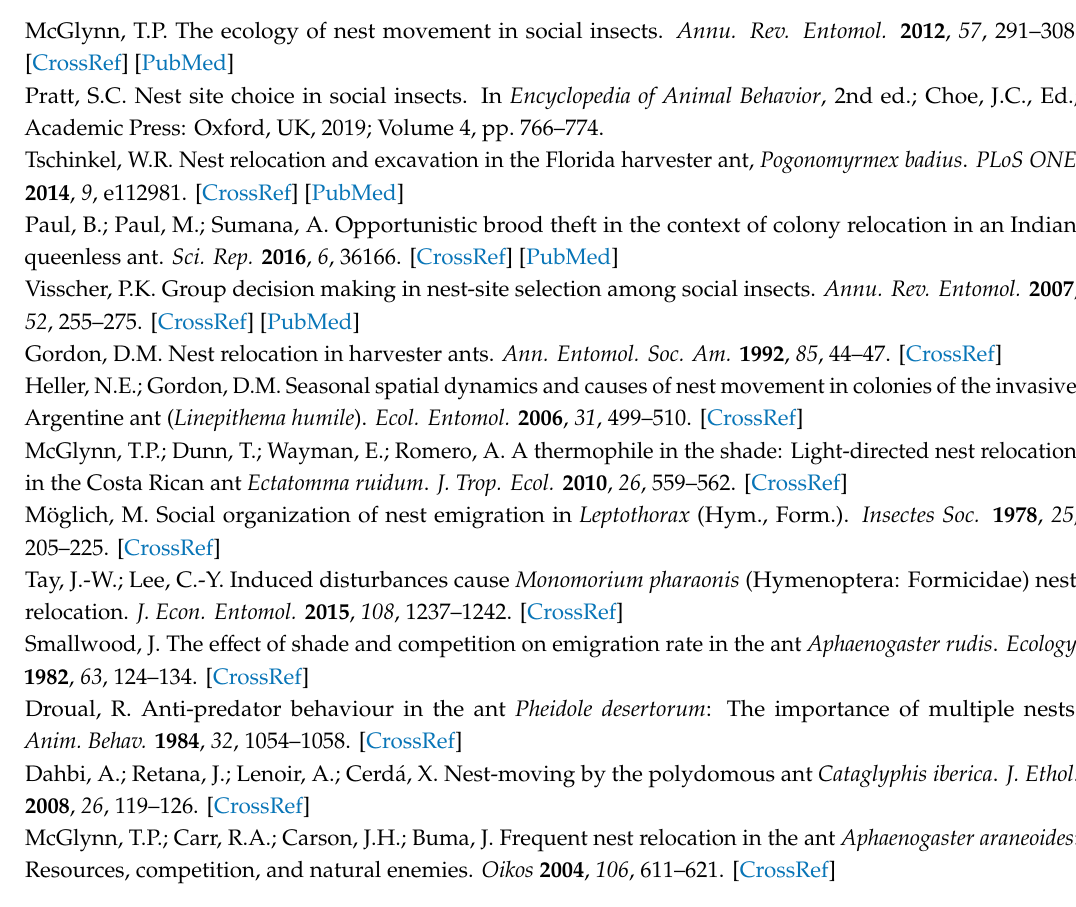
Table S1: Original composition of the Neoponera villosa colonies used in the two-choice bioassays, Figure S1: Taxon ID tree of N. villosa molecular public data, including the 10 sequences from this study (highlighted in yellow), Video S1: Characteristic recruitment behavior in Neoponera villosa . Note that two tandem pairs are following the same path, suggesting the existence of chemical trail